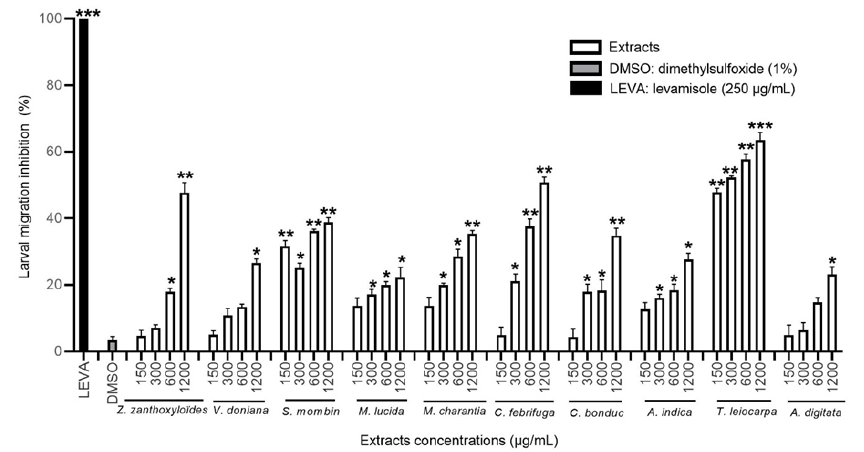
Figure 4. Migration inhibition rate (in %) of H. contortus larvae treated with dichloromethane extracts at different concentrations, DMSO, and levamisole. Asterisks indicate a significant difference compared to the negative control (DMSO) (* p < 0.05, ** p < 0.01, *** p < 0.001). Each histogram represents the mean ± standard deviation from 3 × 3 values.